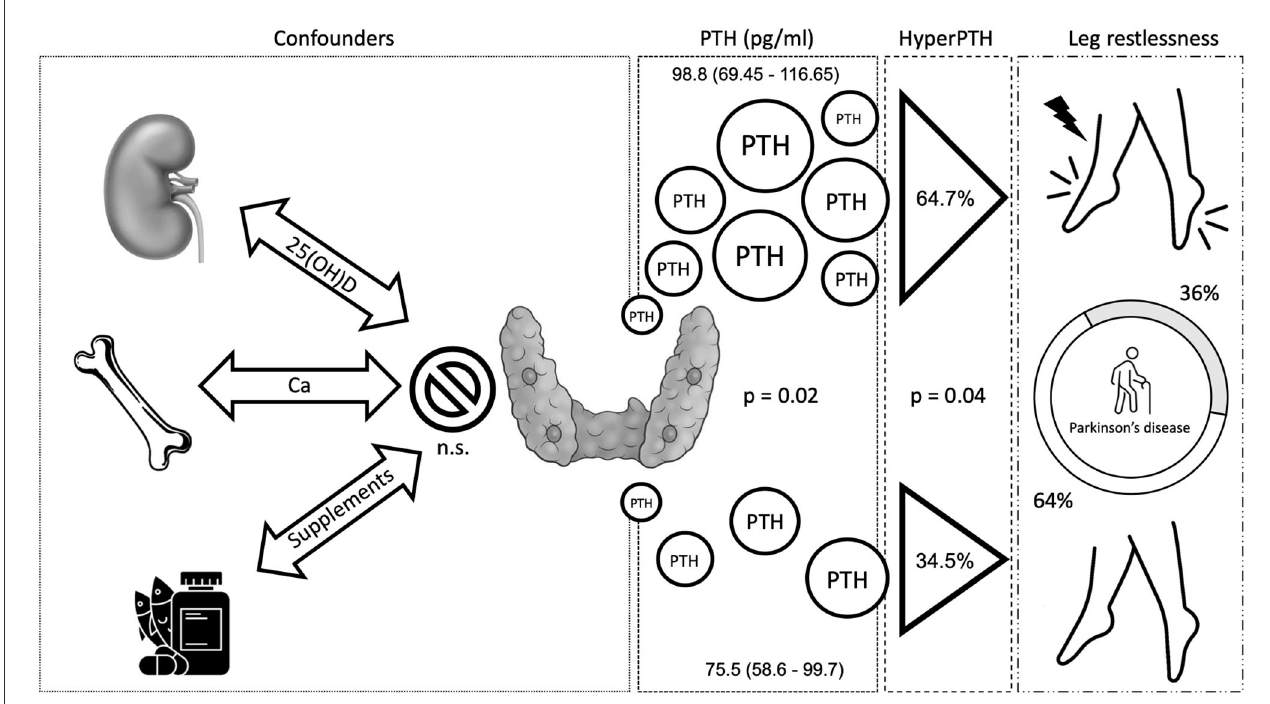
FIGURE1 Hypothetical interrelation between hyperparathyroidism and leg